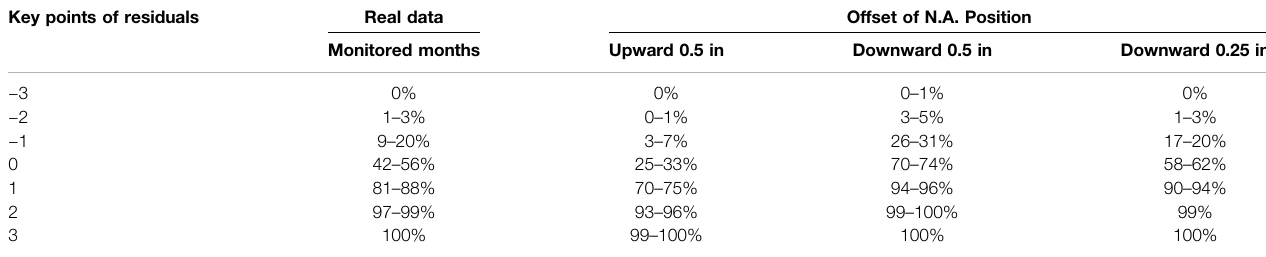
TABLE 2 | Range of cumulative distribution function for key points of residuals for the real data and simulated behavioral changes of N.A. position. Key points of residuals Real data Offset of N.A. Position Upward 0.5